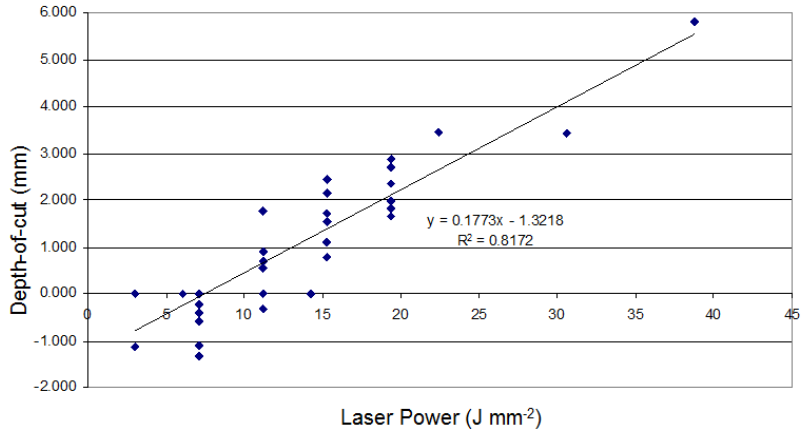
Figure 21. Figure details the regression analysis for the laser power tests that were performed on freshly harvested field-grown cotton plants to determine cutting depth versus laser-power. Results are from plants ranging in height from 250 mm to 725 mm. A zero depth corresponds to the depth where the laser just penetrated through the bark and the phloem tissue. The negative depth indicates insufficient power.